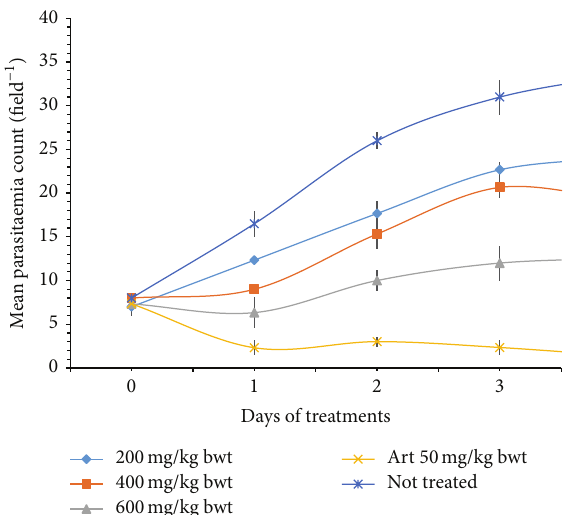
Figure 2: Antiplasmodial activity of crude ethanolic extract of Piper guineense leaf in Plasmodium berghei -infected mice.